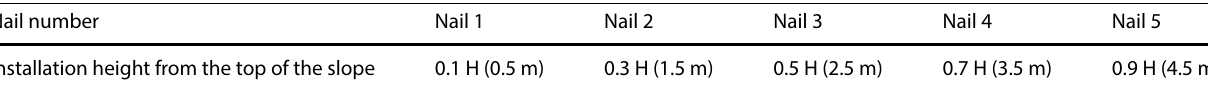
Table 4 Number of nails in different levels of slope Nail number Installation height from the top of the